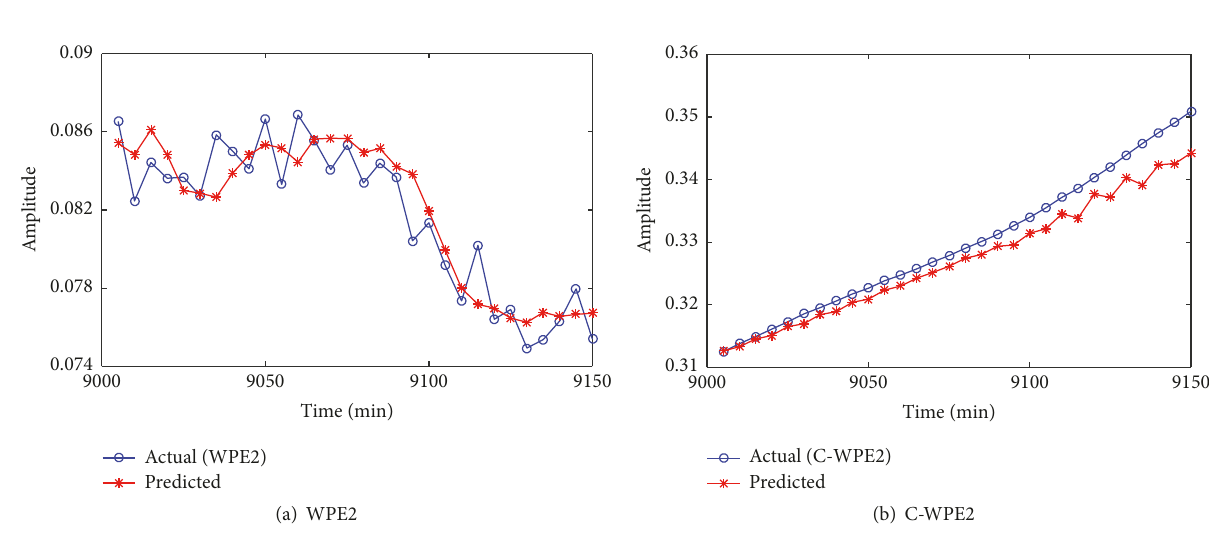
Figure 17: Prediction results of WPE2 and